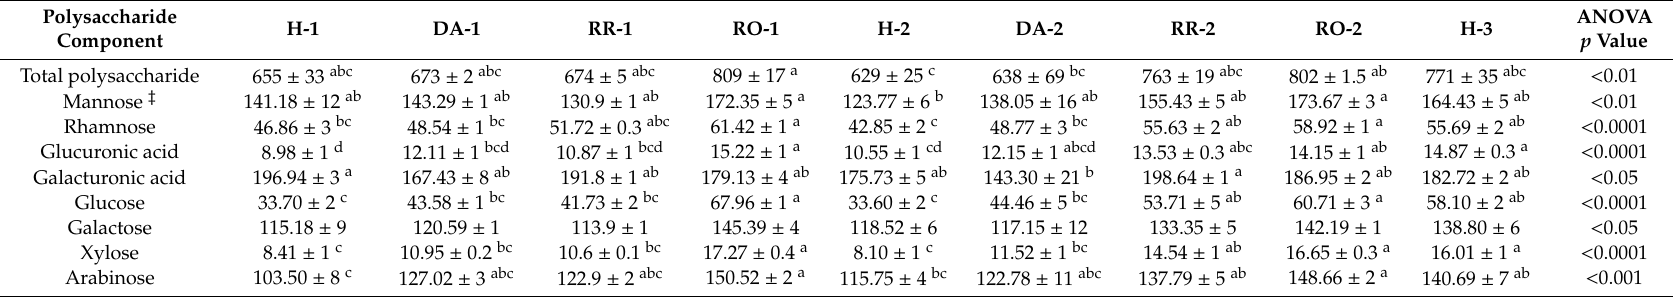
Table 2. Wine total polysaccharide and composition of polysaccharide-derived monosaccharides (as mg / L) in Shiraz wines prepared following harvest time, saigne é and water addition treatments 12 months after fermentation †